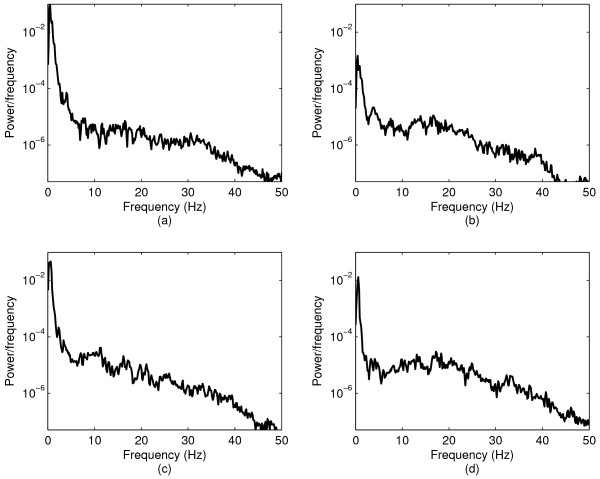
Spectrums of sample signals during the third and fifth steps. Spectrums of sample signals during the third and fifth steps: (a) and (b) depict spectrums of sample signals from the third step in the A-P and S-I directions, while (c) and (d) depict spectrums of sample signals from the fifth step in the A-P and S-I directions.